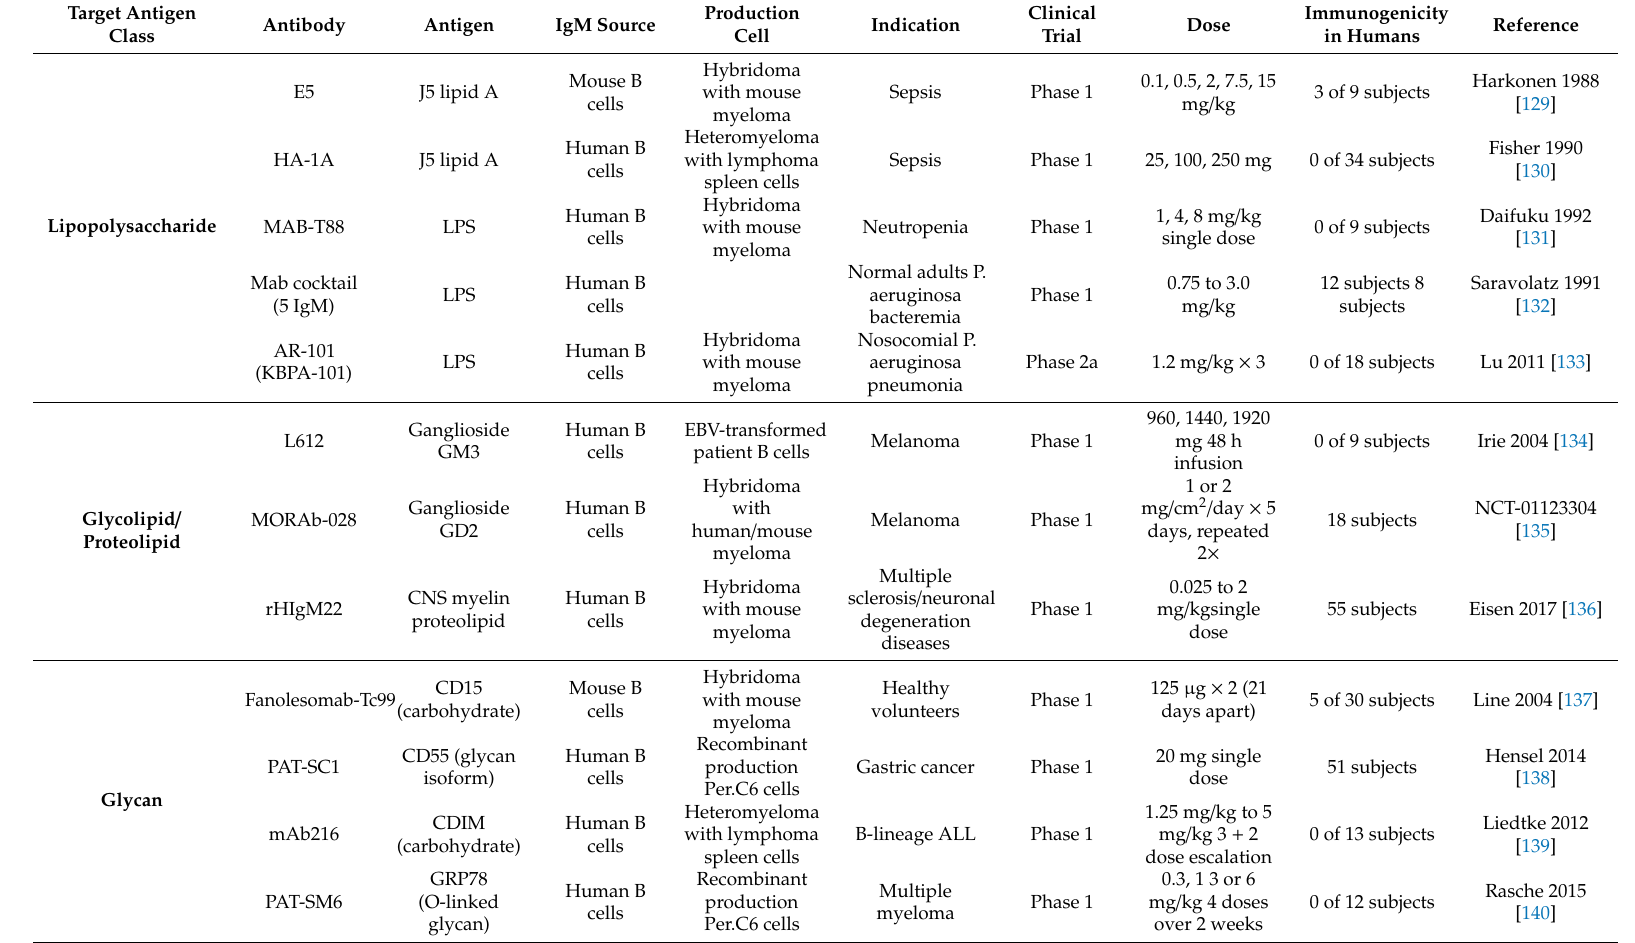
Table 3. Source, production and immunogenicity of IgM antibodies in early phase clinical